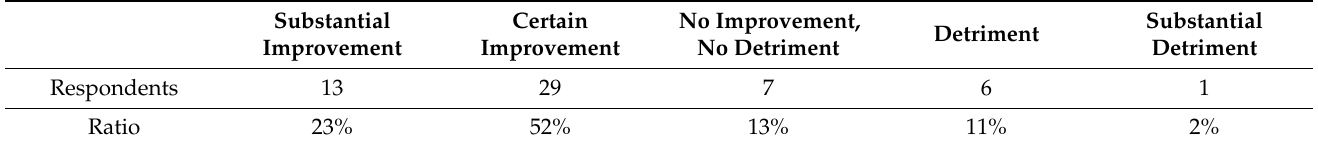
Table 4. Influence of virtual reality on student results.